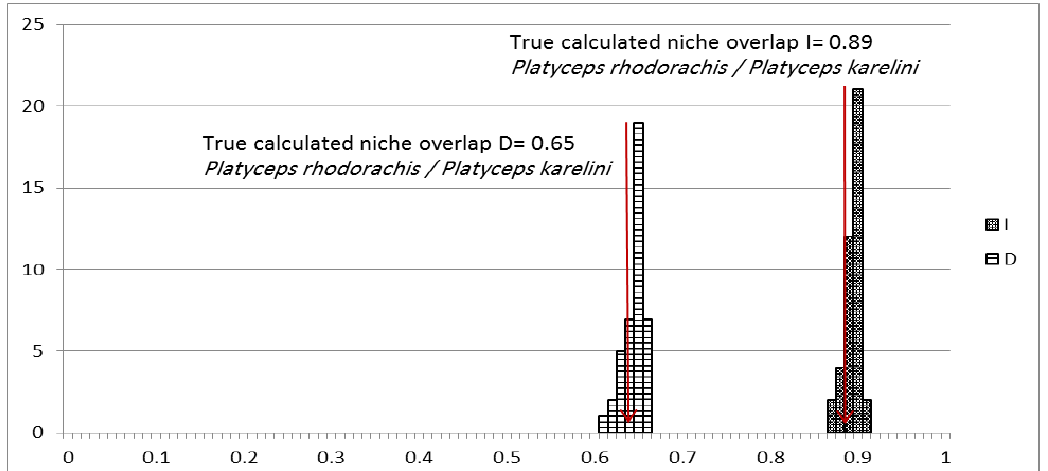
F IGURE 2. Results of the identity test. Red arrows refer to the actual niche overlap as calculated by ENMTools (D and I). The bars (with two different patterns) are calculated by replicates with identity test